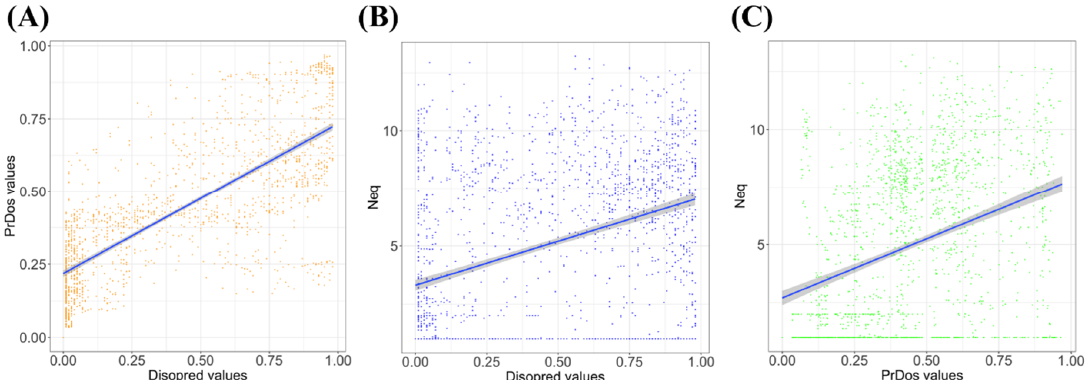
Figure 2 Figure 2. N eq versus prediction disorder results. ( A ) Disopred3 values ( x -axis) against PrDOS values ( y -axis) (correlation equals to 0.75), ( B ) N eq values ( x -axis) against Disopred3 values ( y -axis) (correlation equals to 0.37) and ( C ) N eq values ( x -axis) against PrDOS values ( y -axis) (correlation equals to